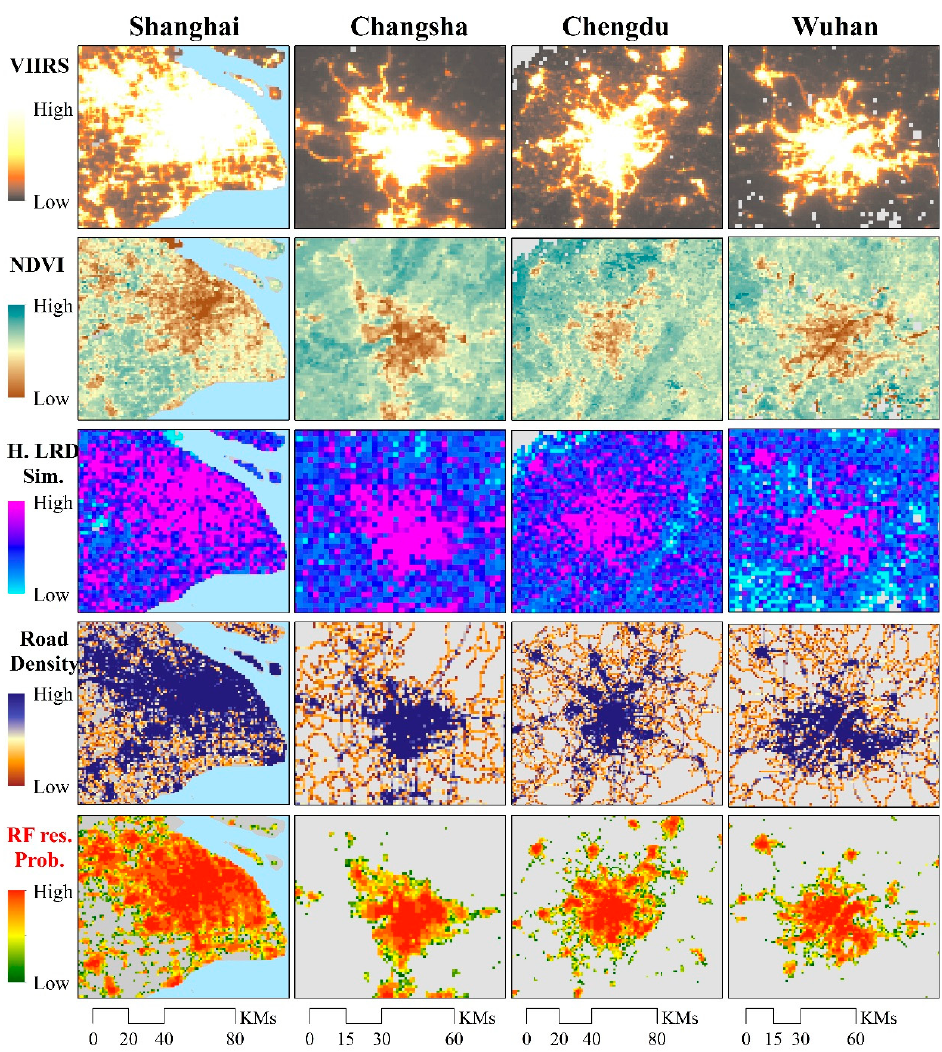
Figure 9. The city-level VIIRS, NDVI, hourly LRD similarity (H. LRD Sim.), road density, and RF probability (Prob.) result for Shanghai, Changsha, Chengdu, and Wuhan, respectively.